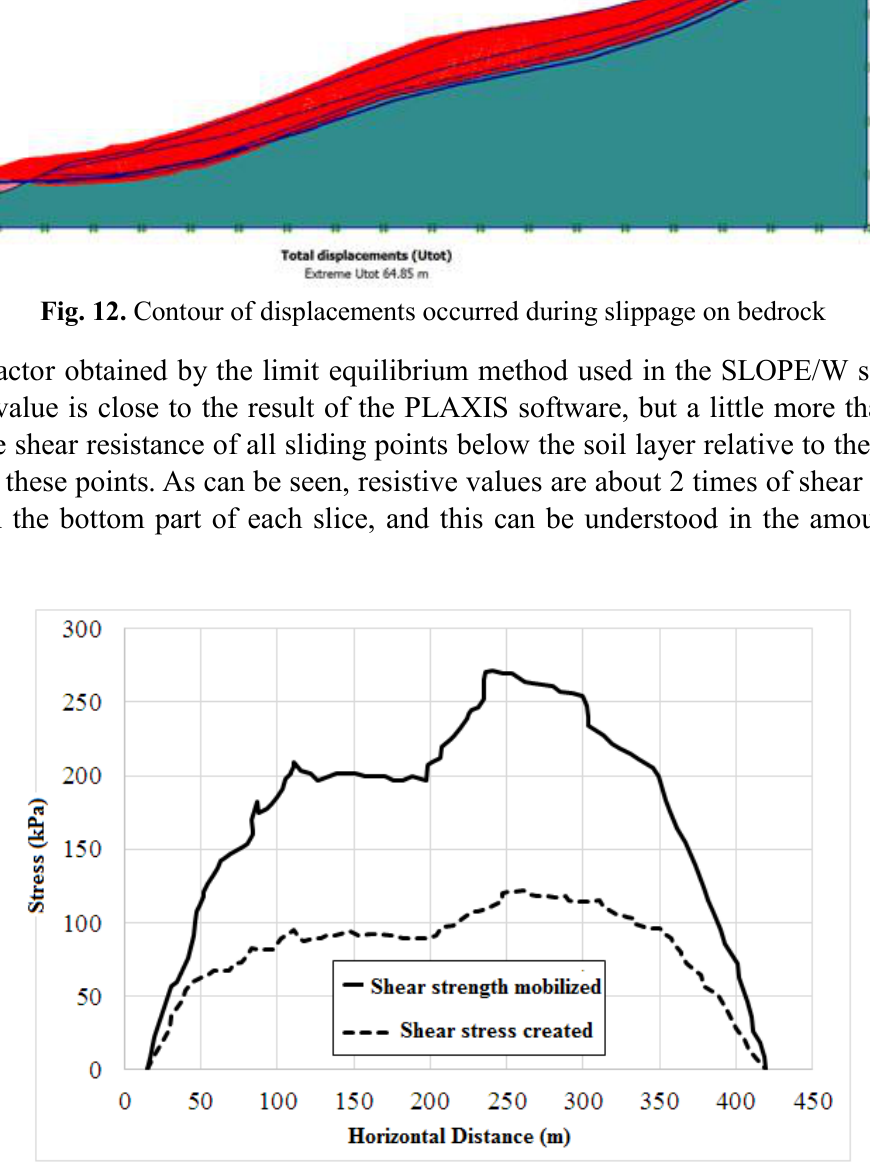
Fig. 13. Comparison of destructive shear stress mobilized and shear resistance on the total slippage